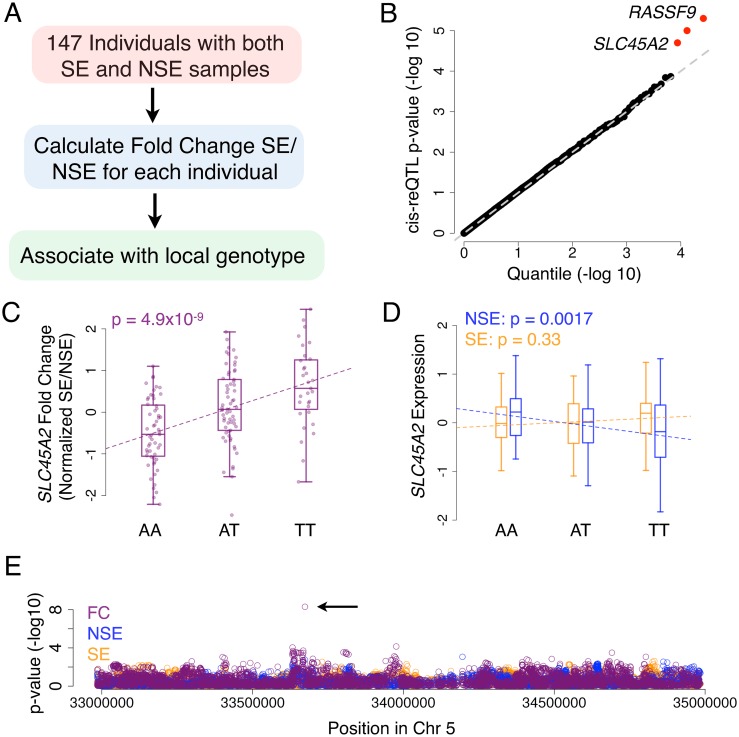
cis-reQTL mapping and SLC45A2 reQTL.(A) Outline of the approach for mapping cis-reQTLs (B) QQ plot of the cis-reQTL p-value for all genes tested. Red indicates the top 3 genes discussed in the text and used in subsequent analyses. (C) Normalized fold change of SLC45A2 expression separated by genotype at the cis-reQTL (rs12653176). p-value calculated from the Spearman correlation. (D) Normalized SLC45A2 expression of the NSE and SE samples separated by genotype at the same locus. p-values calculated from the Spearman correlation. (E) Manhattan plot of the fold change (FC), NSE sample expression, and SE sample expression associations with all SNPs one megabase surrounding SLC45A2. p-values calculated from the Spearman correlation.